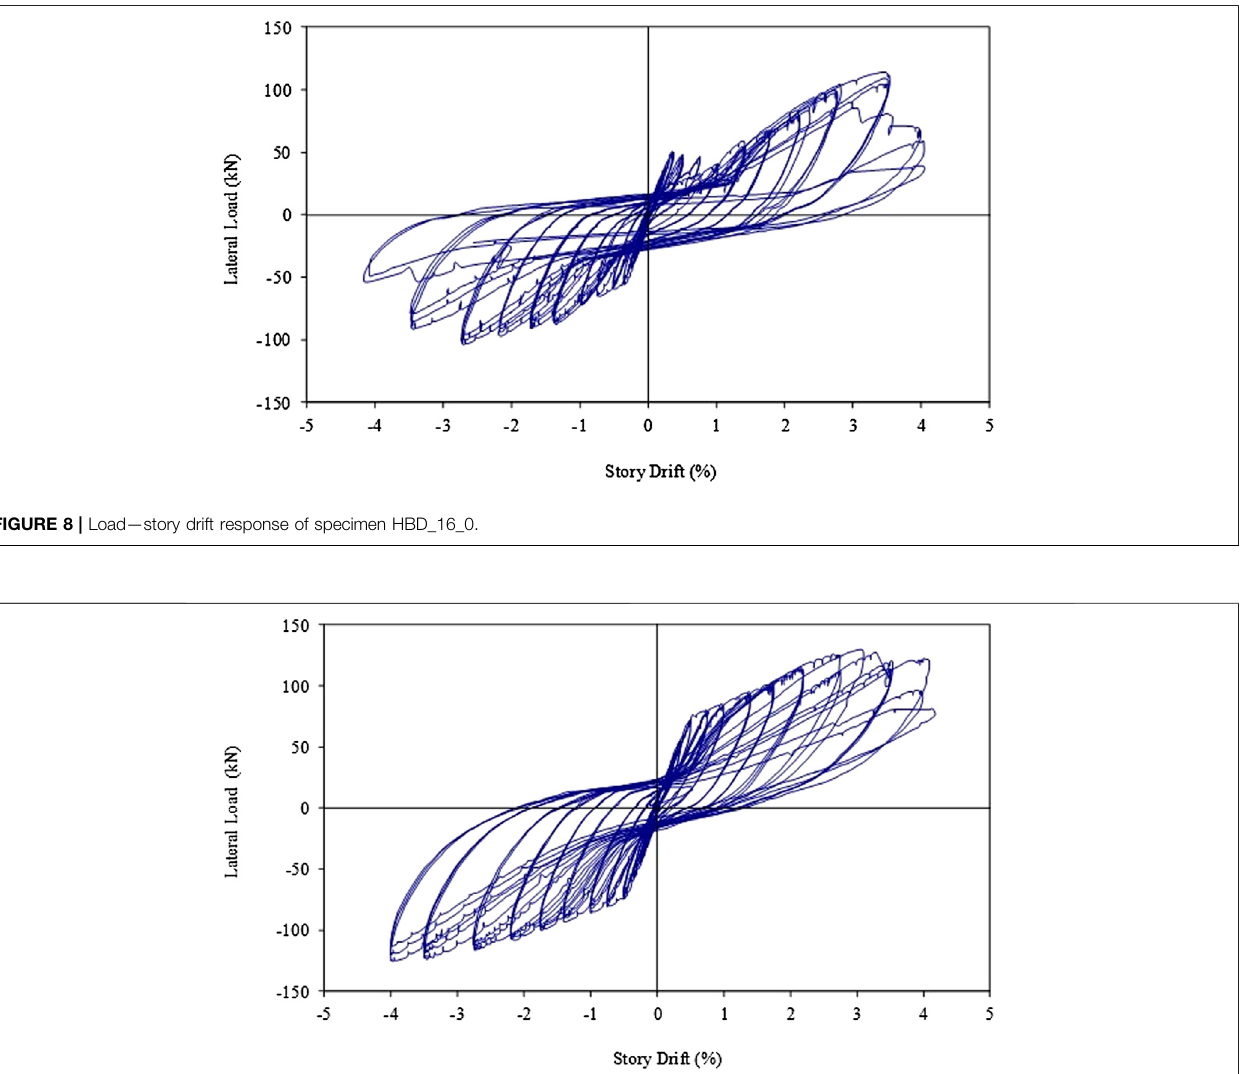
FIGURE 9 | Load — story drift response of specimen